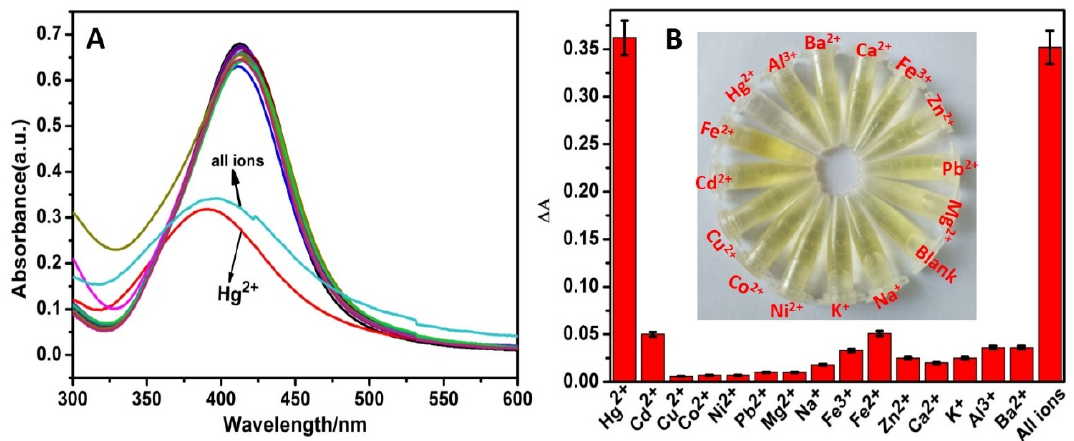
Figure 7. ( A ) UV–VIS absorption spectra and, ( B ) Δ A of the proposed sensing system in the presence of 15 kinds various metal ions and mixed all ions (the concentrations of all metal ions are 50 μ M).